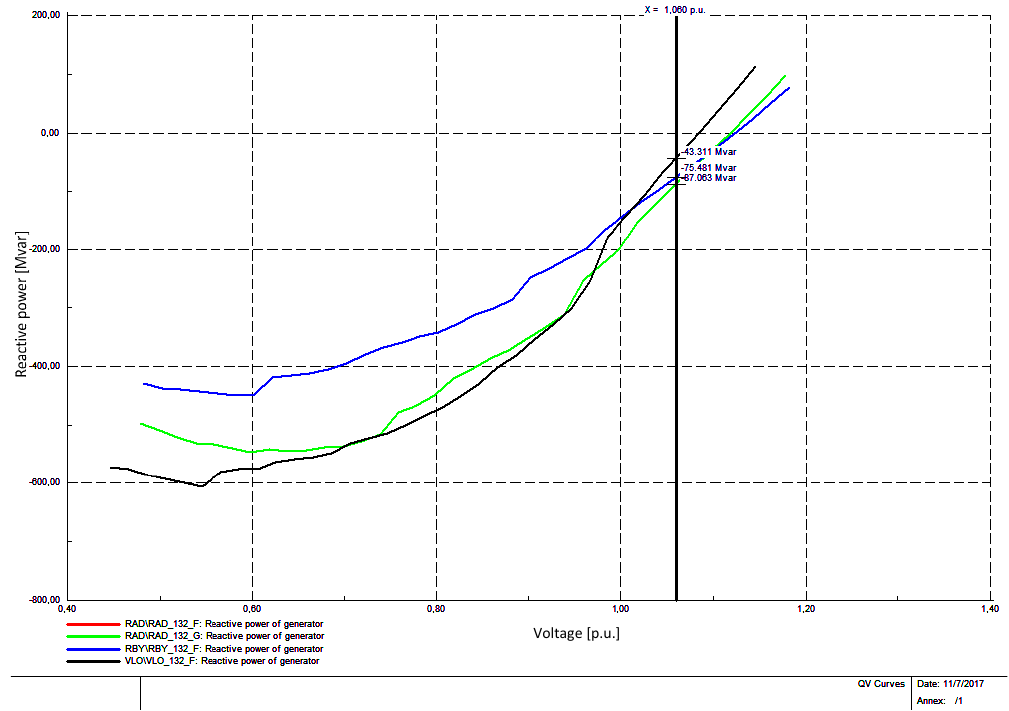
Figure 7. QV-analysis of the 3rd contingency, in the southern area of Zealand. Figure 7. QV ‐ analysis of the 3 rd contingency, in the southern area of Zealand.